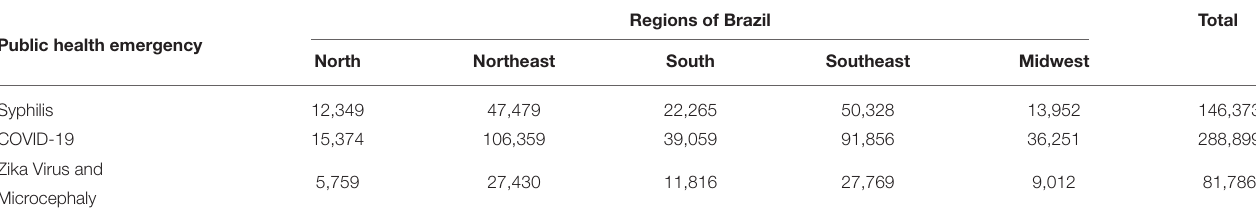
TABLE 1 | Total number of attendees during three Brazilian public health